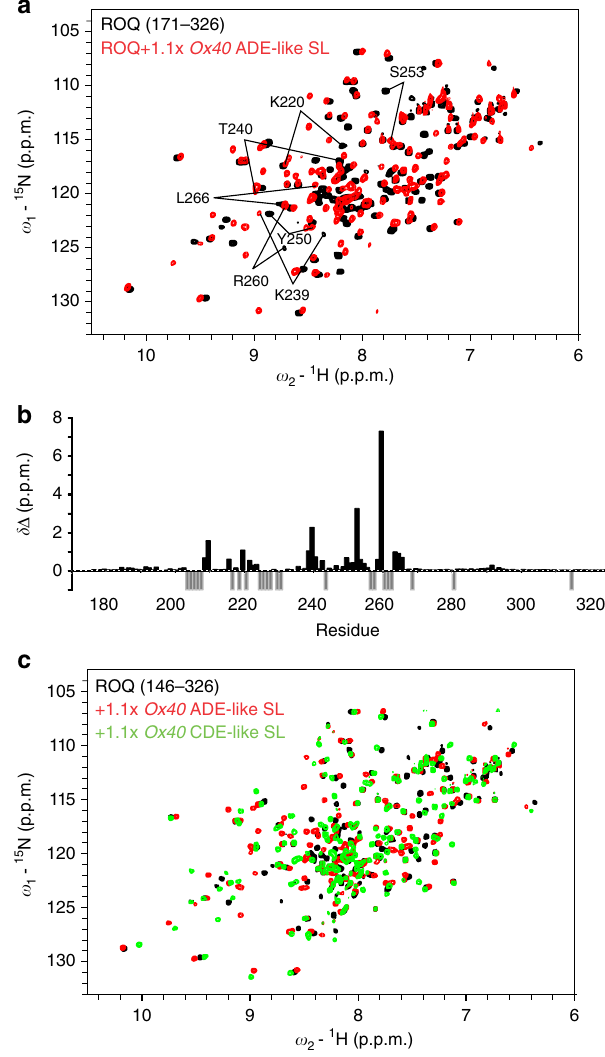
Figure 4 | NMR analysis of ROQ domain interactions with the Ox40 ADE-like hexaloop RNA. ( a ) Overlay of 1 H, 15 N HSQC spectra of either the free ROQ domain (171–326, black) or in complex with stoichiometric amounts of the Ox40 ADE-like SL (red). Selected shifts of amide resonances are indicated. ( b ) Plot of chemical shift change versus residue number in the ROQ domain (residues 171–326) from a . Grey negative bars indicate missing assignments in one of the spectra. Gaps indicate prolines. ( c ) Overlay of the ROQ domain alone (black) or in complex with the Ox40 ADE-like SL (red) or the Ox40 CDE-like SL (green). See also Supplementary Notes and Supplementary Fig.